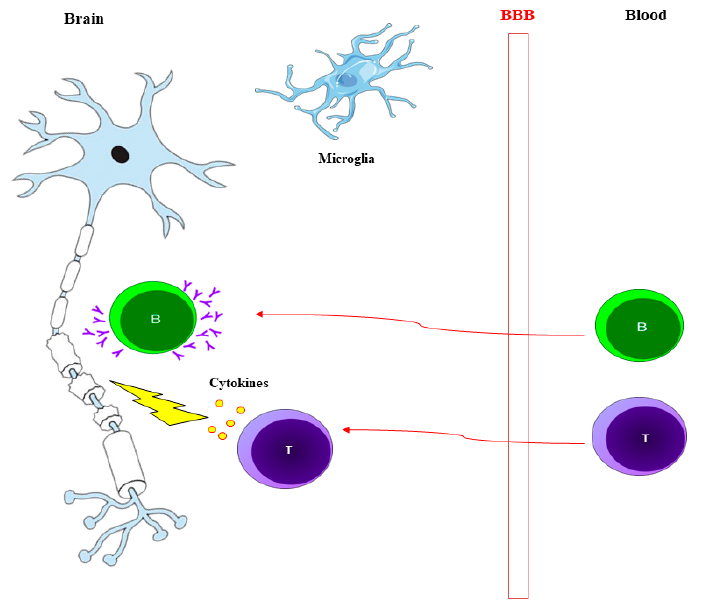
Figure 1. T-cells enter the blood brain barrier (BBB) and release cytokines which degrade the myelin. The cytokines can also recruit some other cells as B-cells. These cells enter the BBB and produce antibodies which target the myelin for further degradation. Activated microglia are also involved in myelin degradation.